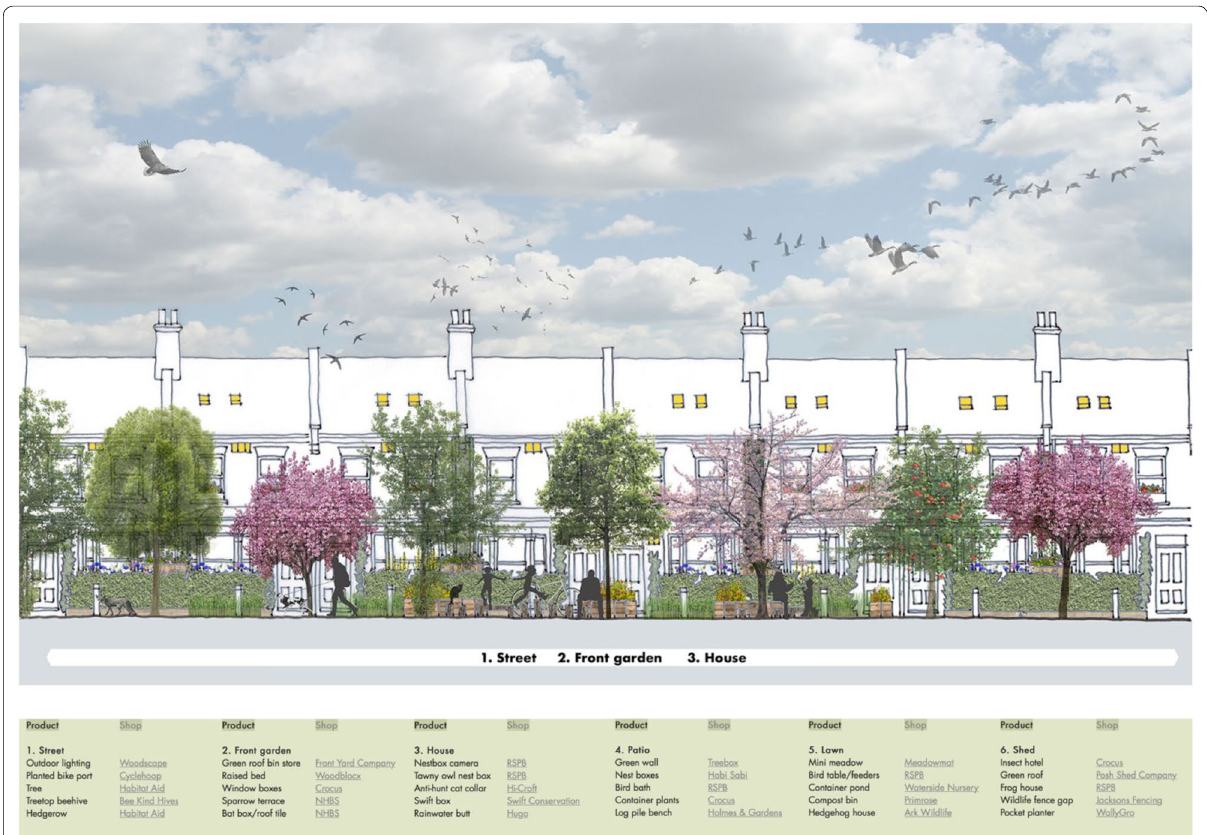
Fig. 3 Street elevation showing proposed typical street with adaptations for biodiversity, focusing on products (Siân & Jon Moxon & Viktoria